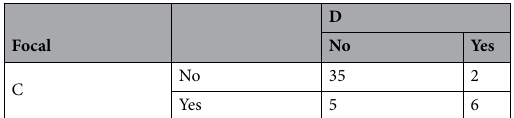
Table 3. Frequency table showing the pairs of observers with the median Kappa (0.54) regarding the interpretation of focal skeletal/bone marrow uptake. Grey fields indicate agreement between physicians C and D.